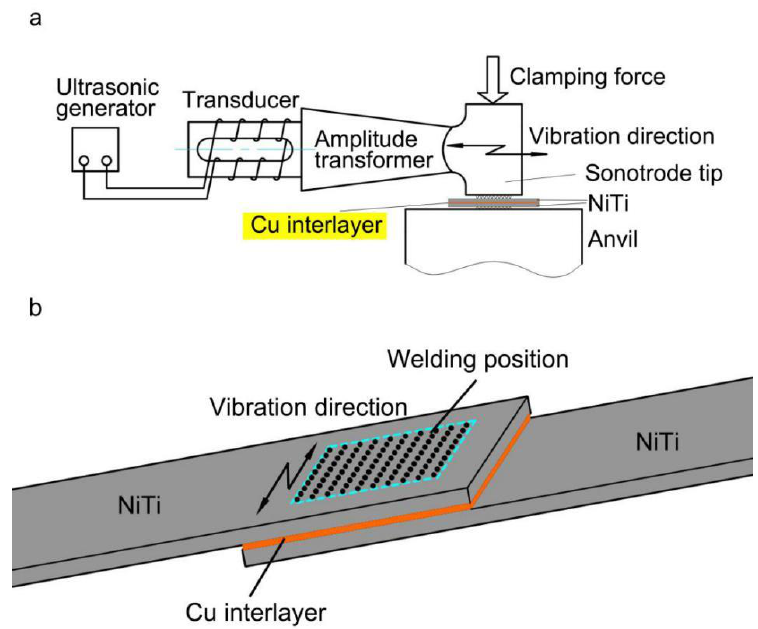
Figure 1. ( a ) Schematic illustration of USW process; ( b ) Schematic diagram showing the welding position of NiTi with Cu interlayer.